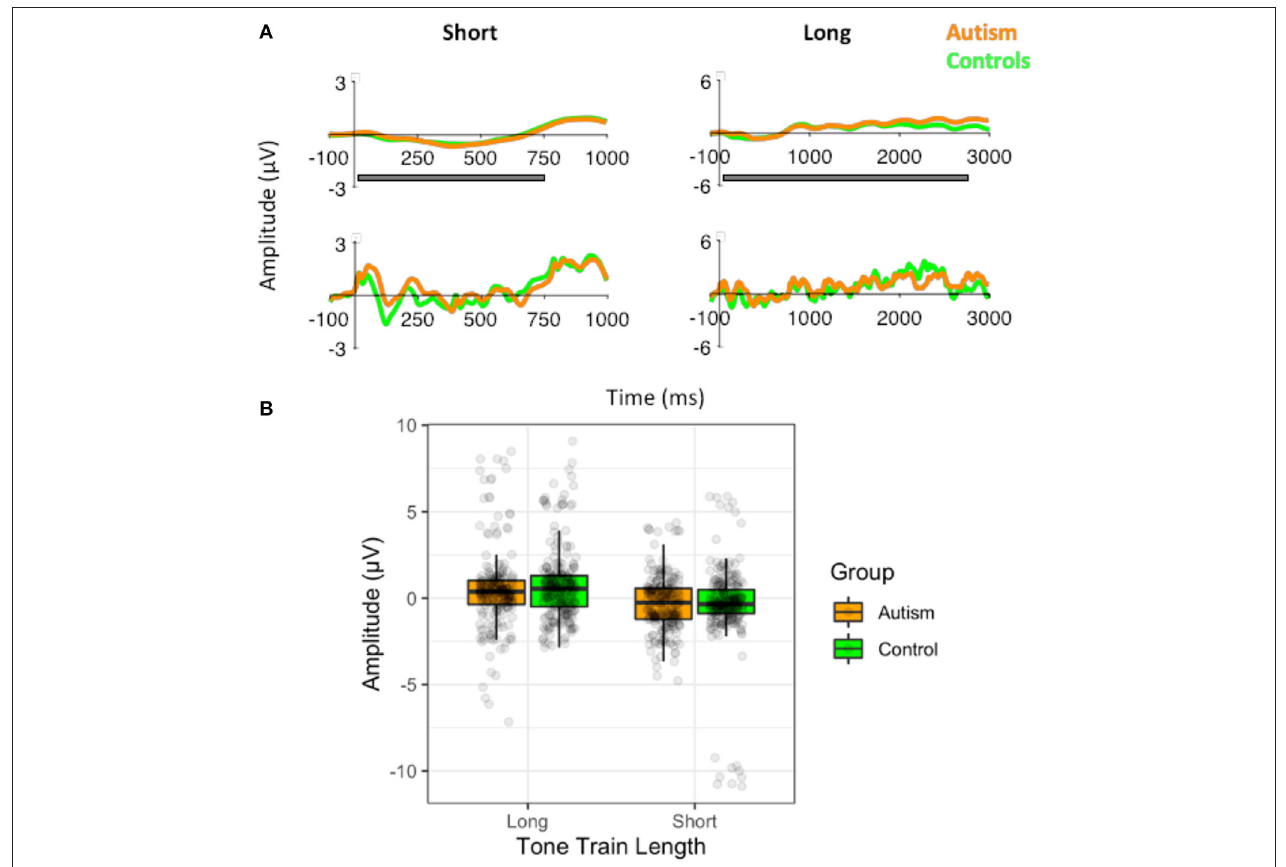
FIGURE 5 | (A) Waveforms to the short (3) standard tone trains and the long standard tone trains (10) filtered at 1.5Hz for the analysis of the slow-wave (top) and without the filtering (i.e., the original filtered data for the MMN analysis; bottom), shown separately for individuals with autism and neurotypical controls. Both versions of the filtered waveforms are shown to illustrate the slow-wave that was analyzed and how it arose from the original data used to calculate the MMN. The gray bar indicates the window use for the slow-wave analysis. (B) Amplitudes of the slow-waves for the long and the short standard tone trains shown separately for individuals with autism and neurotypical